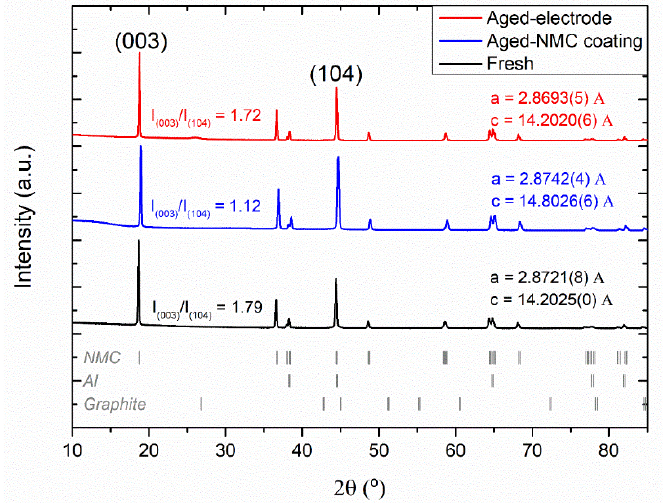
Figure 6. X-ray diffraction patterns of the fresh (black line), aged-NMC (blue line) and aged-electrode (red line) coatings. (003)/(104) peak intensity ratios, theoretical reflections for NMC, graphite and aluminum and unit cell parameters for the fitting of each diffractogram are included.